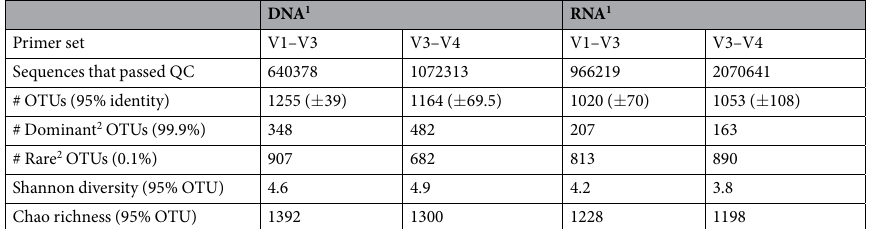
Table 1. Statistical analysis of sequencing data. 1 Data presented is average of the six samples. 2 Dominant OTUs are the number of OTUs to which 99.9% of all the sequence reads clustered whereas rare OTUs only contain the remaining 0.1% of the total number of reads.